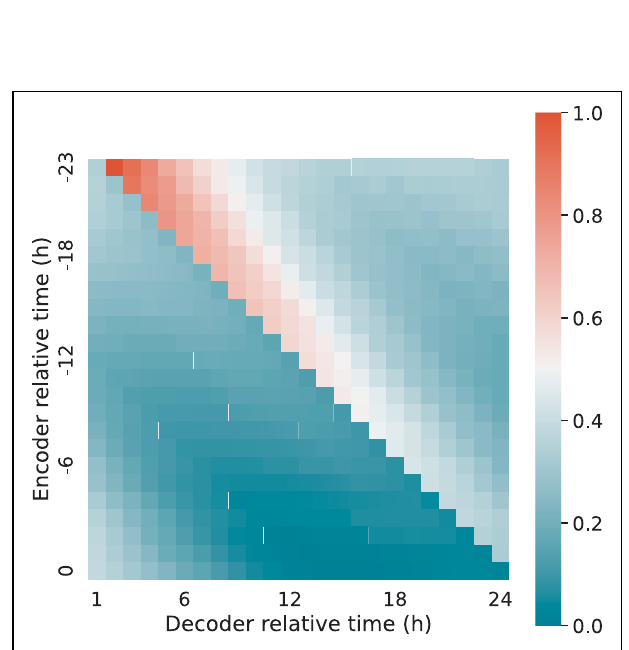
FIGURE 7 | Heatmap of attention weights aggregated per time. The horizontal axis represents the entity being input, and the vertical axis denoted the entity being